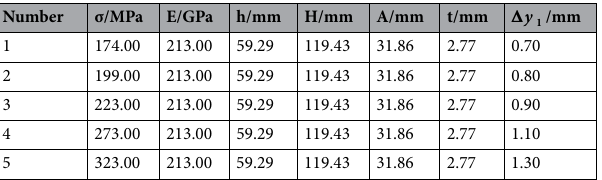
Table 3. The macroscopic loading by four-point bending for treated 35CrMo